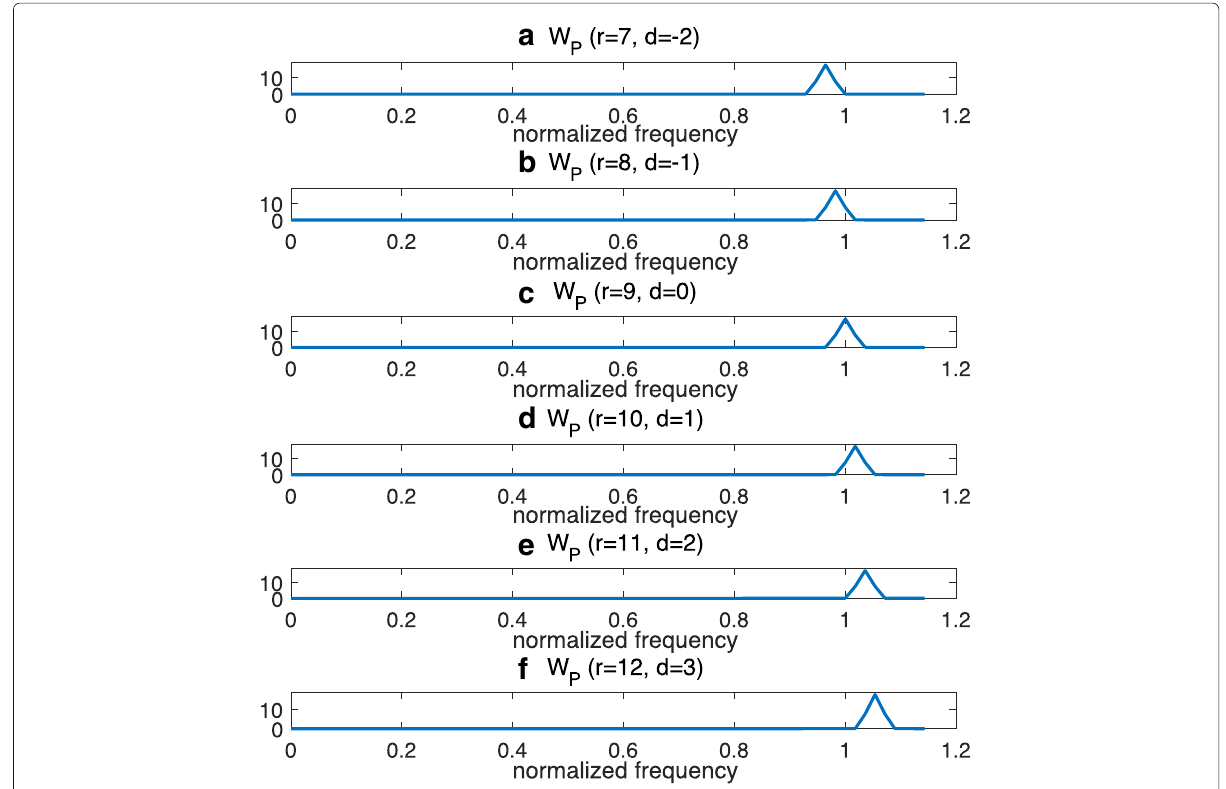
Fig. 5 Echo frequency basis vectors at a r = 7, b r = 8, c r = 9, d r = 10, e r = 11, and f r = 12 (input SRR = − 12 dB). The x -axis of each graph denotes frequency normalized by the CW ping